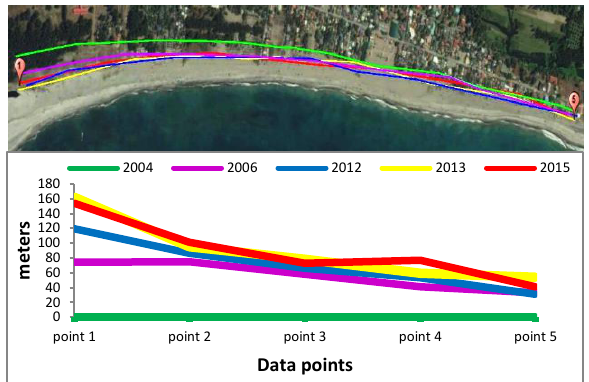
Figure 10. South side of Santo Tomas Coastal